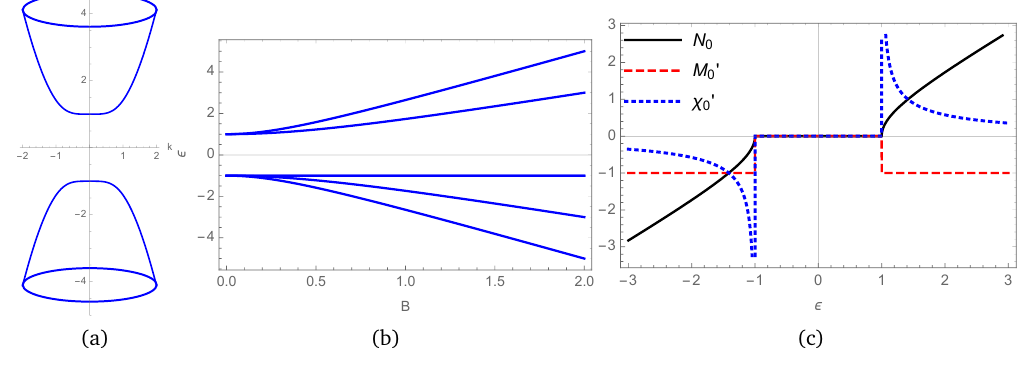
(cid:112) 2 m ∆ ] . ] for 2 π [ black 0, ξ